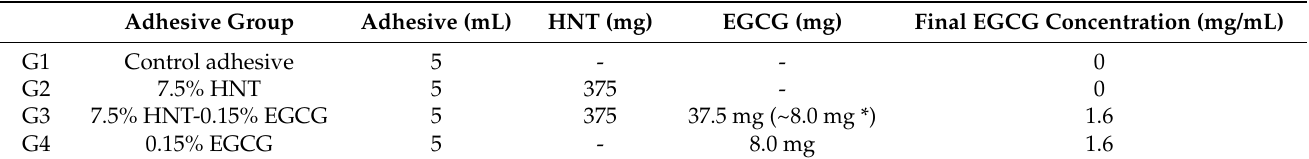
Table 1. Summary of the adhesive groups with the ratios of the components and the final EGCG